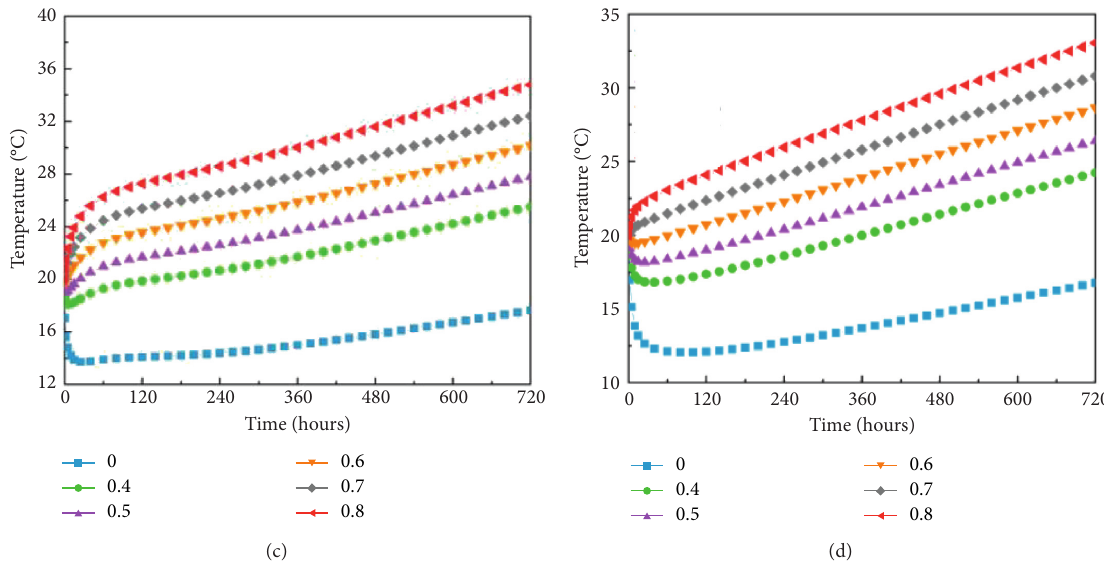
Figure 12: Temperature-time curves with different solar absorption coefficients. (a) Point A, (b) point B, (c) point C, and (d) point D.